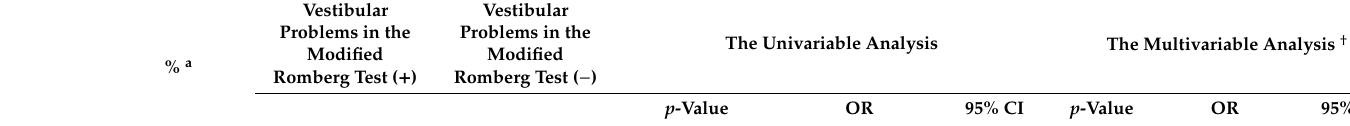
Table 2. Analysis of factors potentially associated with “vestibular problems in the modified Romberg test” in participants over 50 years